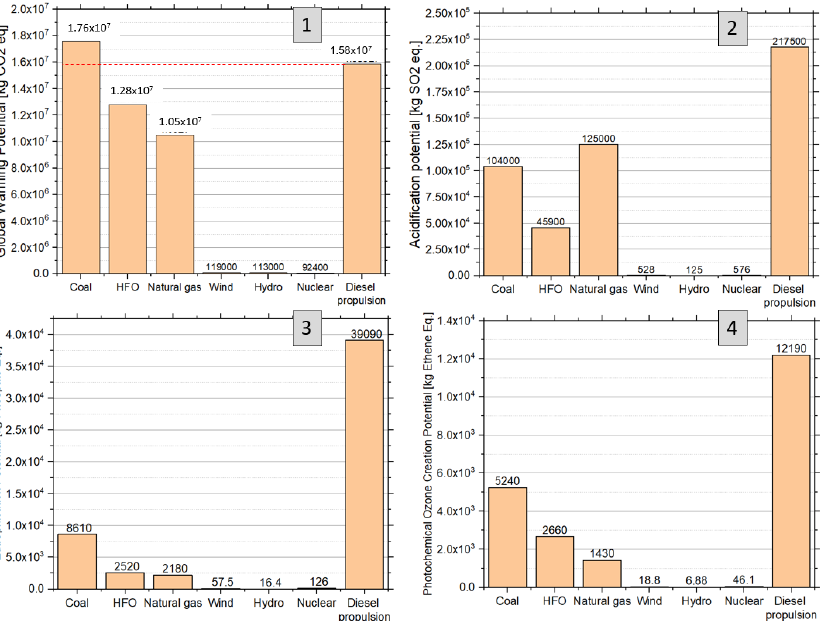
Figure 14. LCA results with various energy sources for electricity generation: ( 1 ) GWP, ( 2 ) AP, ( 3 ) EP and ( 4 ) POCP.